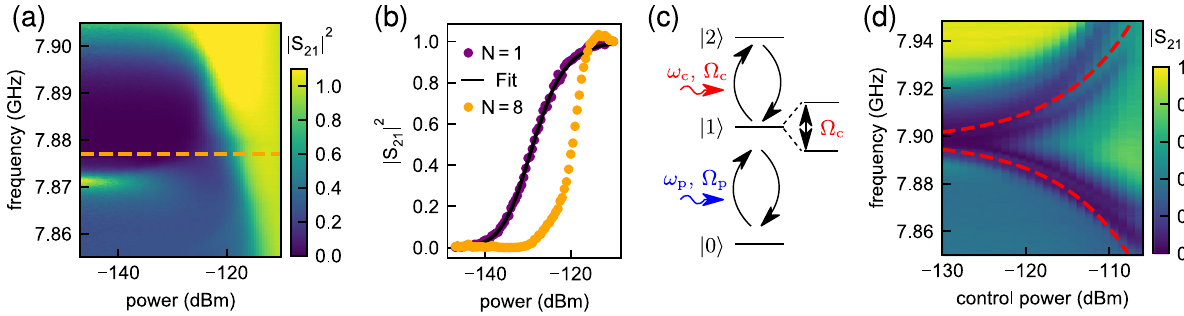
Fig. 4 Power saturation and Autler-Townes splitting. a Absolute power transmission ∣ S 21 ∣ 2 for N = 8 resonant qubits shows saturation with increasing power due to the anharmonic level structure of the transmons. b Comparison between the saturation of ∣ S 21 ∣ 2 at ω r for a single qubit and N = 8 qubits. c Schematic illustration of the Autler-Townes effect for a ladder-type three-level system. A control tone is driving the 1 → 2 transition with Rabi strength Ω c and frequency ω c , while a weak tone is probing the transmission of the 0 → 1 transition. d Experimental demonstration of the collective Autler-Townes splitting for N = 8. The red dashed line marks the fi tted level separation to Ω c